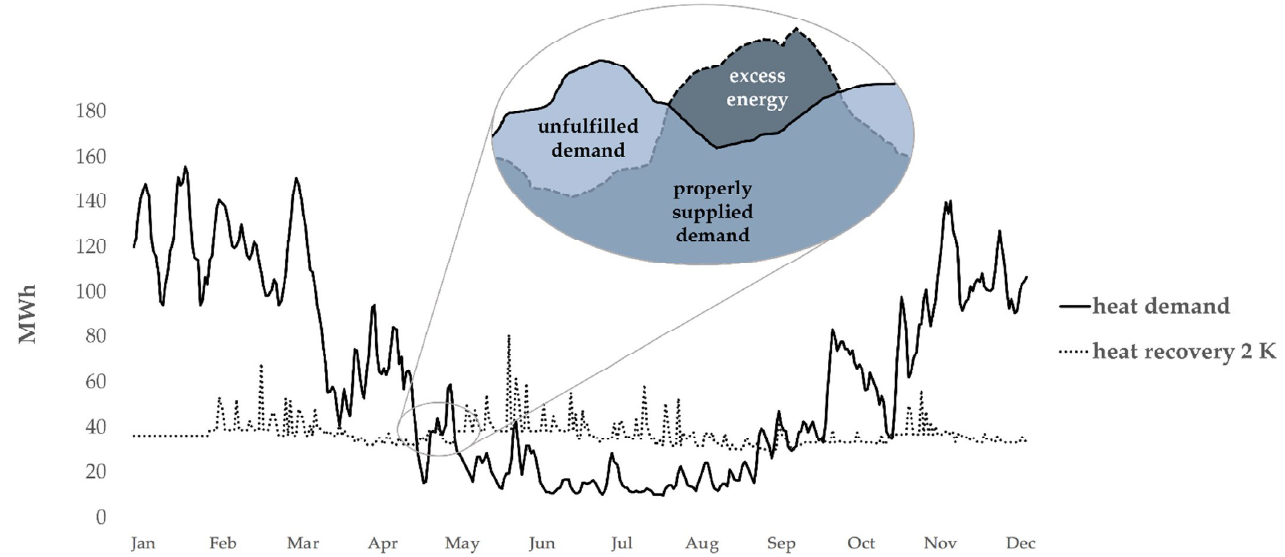
Figure 8. Daily heat demand in the proposed energy zones of the study area and heat recovery from the WWTP in 2016 (own illustration).